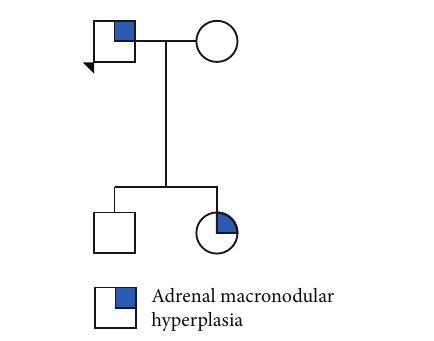
Figure 7: Family tree: 1. Proband, 2. affected daughter, 3. healthy son. Circles: females; squares: